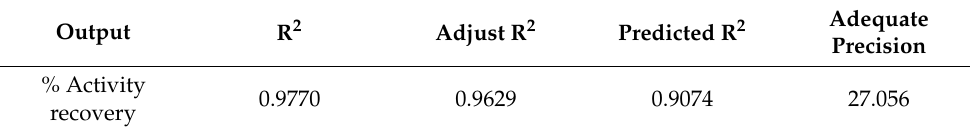
Table 3. Statistical coefficients of hMBCOMT storage stability